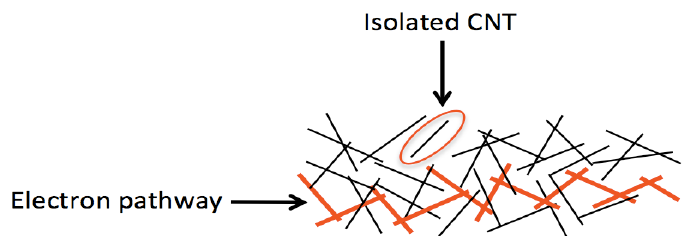
Figure 1. Random carbon nanotube network showing both isolated carbon nanotube and formation of electron pathway via overlapping carbon